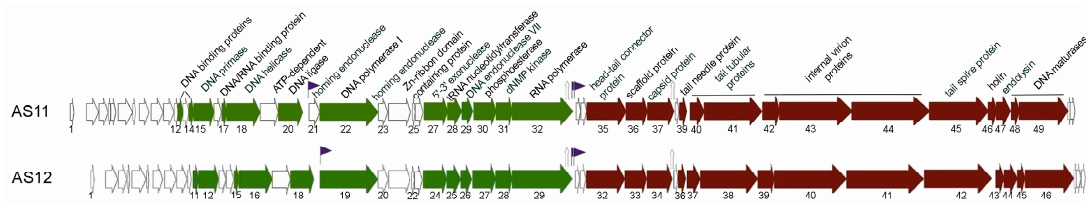
Figure 3. Comparison of AS11 and AS12 genomes. The AS11 and AS12 genomes are schematically presented. Open reading frames (ORFs) are indicated as arrows, the direction of an arrow shows the direction of transcription. The ORFs are colored according to functional predictions: green for genes coding enzymes of nucleotide metabolism and proteins involved in DNA replication and repair; red for virion and lysis protein genes. Overrepresented motifs that likely function as putative phage-encoded RNAP promoters are indicated as violet flags. Terminators are shown as hairpins.